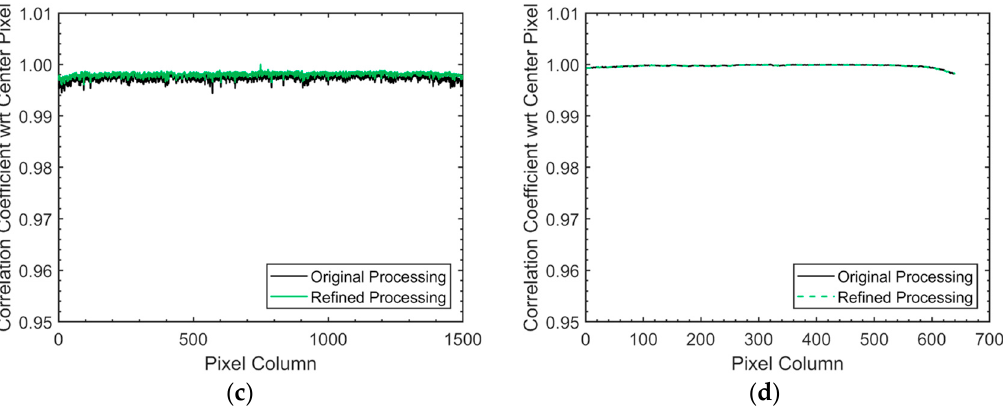
Figure 17. The CCs calculated across the field-of-view with respect to the spectrum complementary to the windows in Table 3. ( a ) CASI imagery (23 June 2016); ( b ) SASI imagery (23 June 2016); ( c ) CASI imagery (24 June 2016); ( d ) SASI imagery (24 June 2016). ( a,c ) The CCs of the CASI imagery increased greatly, especially along the edges, indicating that the error was primarily contained within the spectral regions identified in Table 3. The CASI data from the 23rd were relatively consistent between both processing methodologies. Although this trend generally held for the data from the 24th, ( c ) showed a notable offset. ( b,d ) The large reduction in the CCs from the SASI imagery at Pixels 548–564 was not present after removing the problematic band that was found between 993 and 1008 nm.